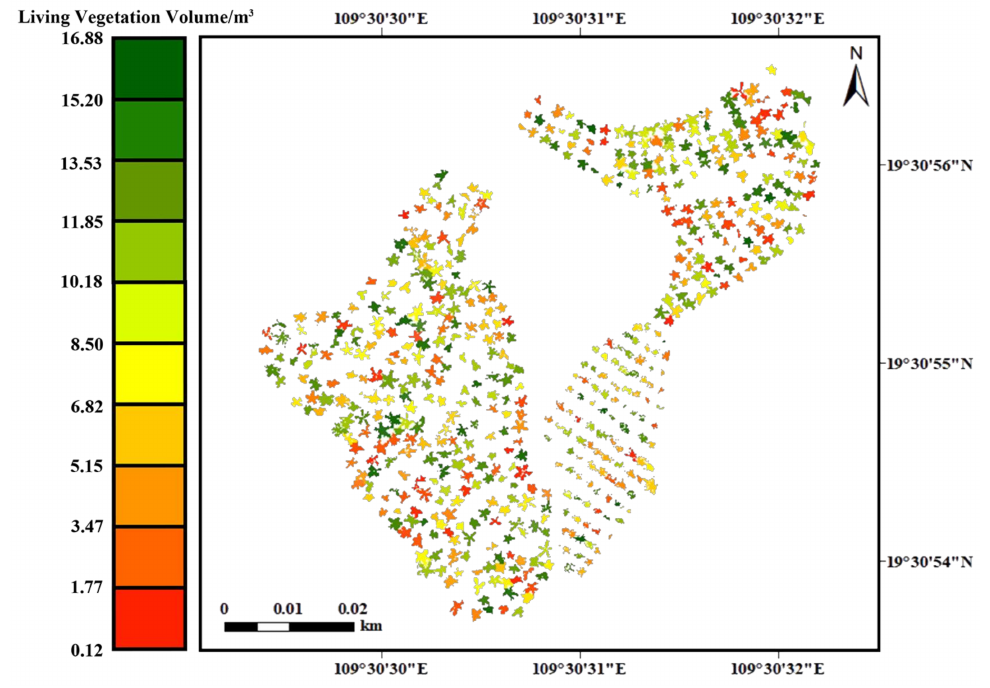
Figure 9. LVV distribution of areca in the research area.